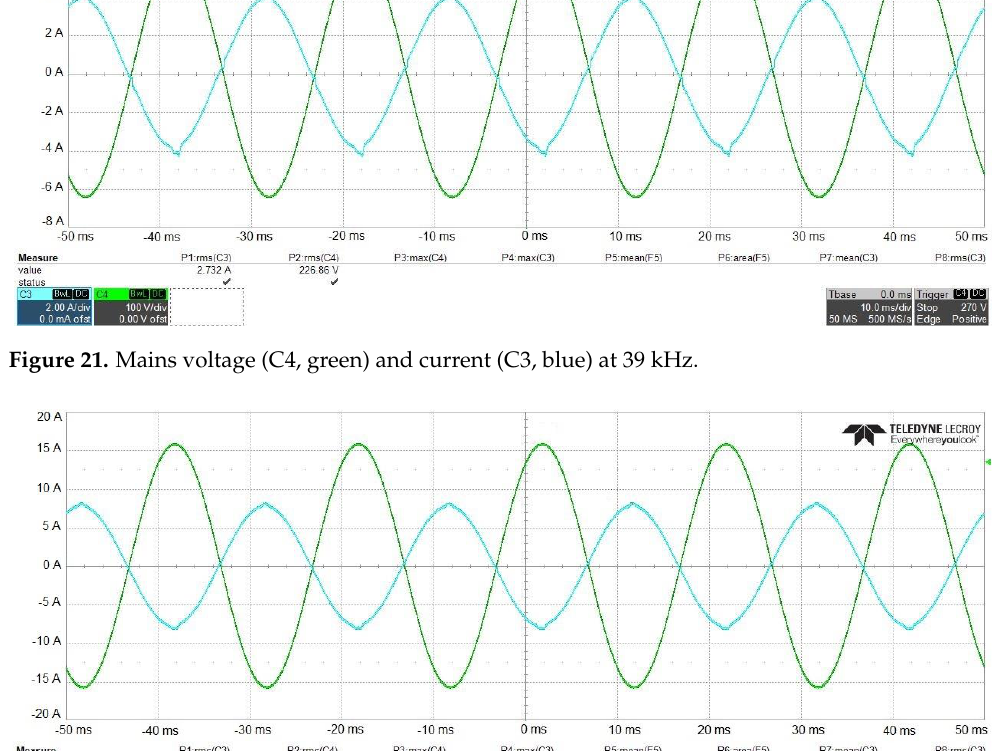
Figure 22. Mains voltage (C4, green) and current (C3, blue) at 31 kHz.